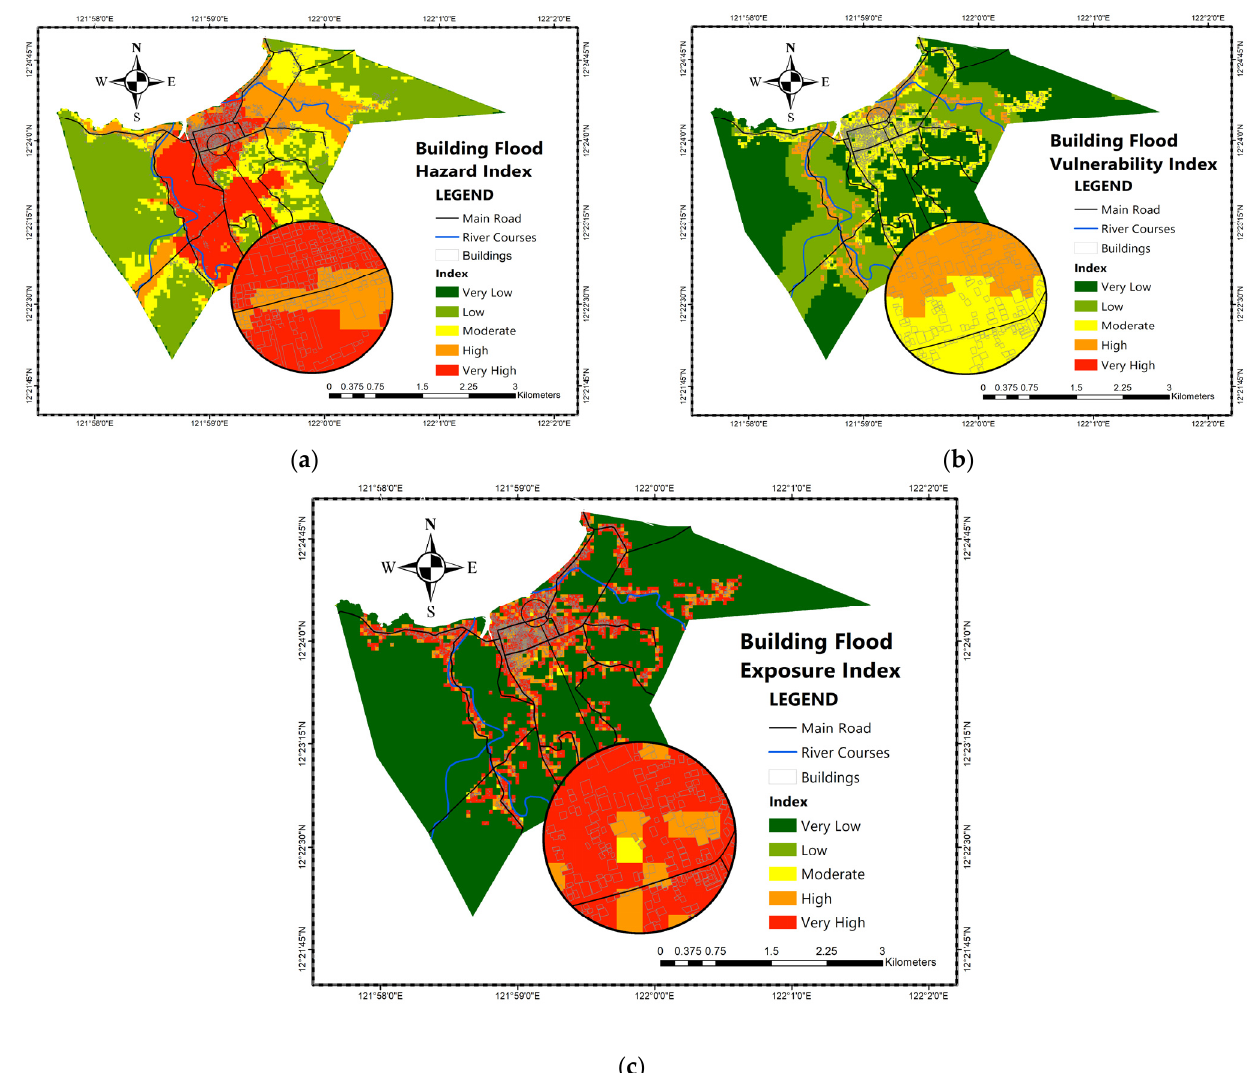
Figure 7. Generated maps from the different parameters in ( a ) building flood hazard, ( b ) flood vulnerability, and ( c ) flood exposure of the town proper of Odiongan, Romblon.